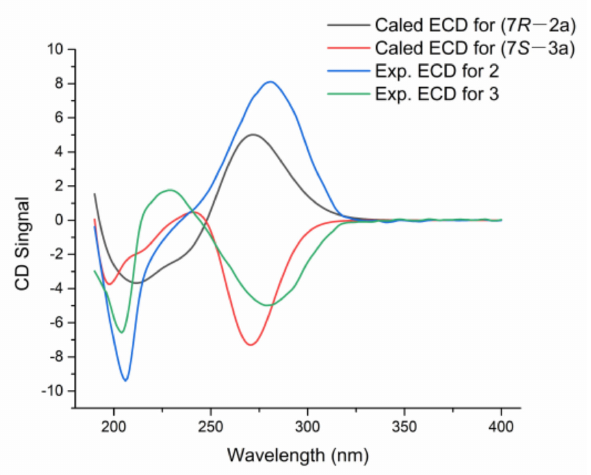
Figure 4. Experimental ECD spectra of 2 / 3 and calculated ECD spectra of 2a / 3a .